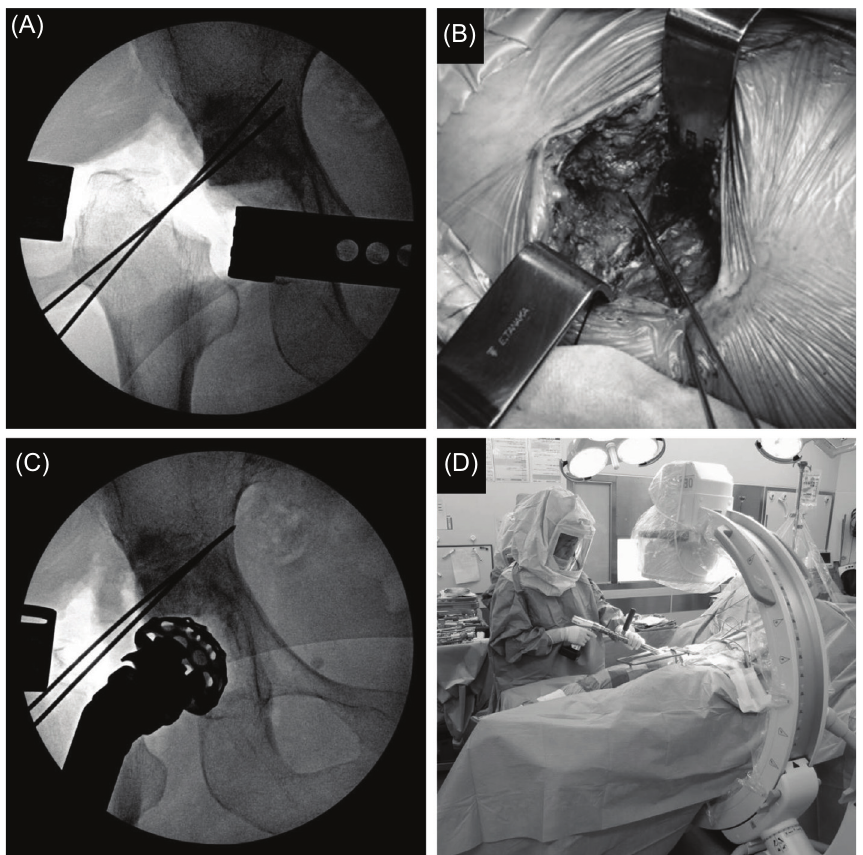
Figure 4. (A, B) For bone defects in the weight-bearing region of the hip joint, autologous femoral head was trimmed, and temporary fixation with it as bulk bone was applied using Kirschner wire. (C, D) Since the KT plate is dome-shaped, it is necessary to remove an excess portion of the temporarily fixed bone graft using a slightly smaller reamer. It was also confirmed by fluoroscopy as needed.